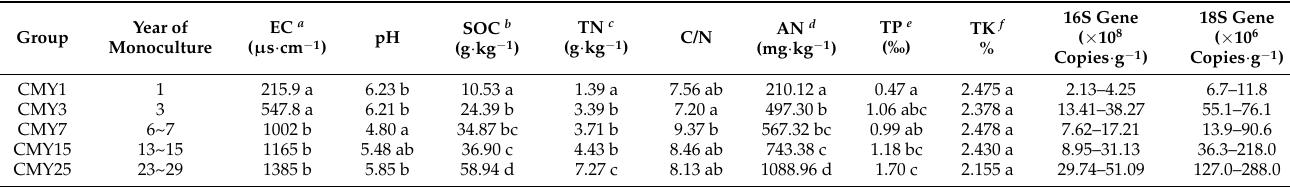
Table 1. Soil abiotic properties and microbial abundances under different periods of cucumber monoculture under greenhouse